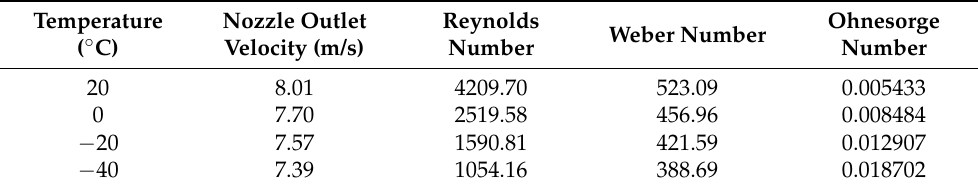
Table 1. Spray velocity, Reynolds number, Weber number and Ohnesorge numbers at the nozzle outlet at different temperatures.